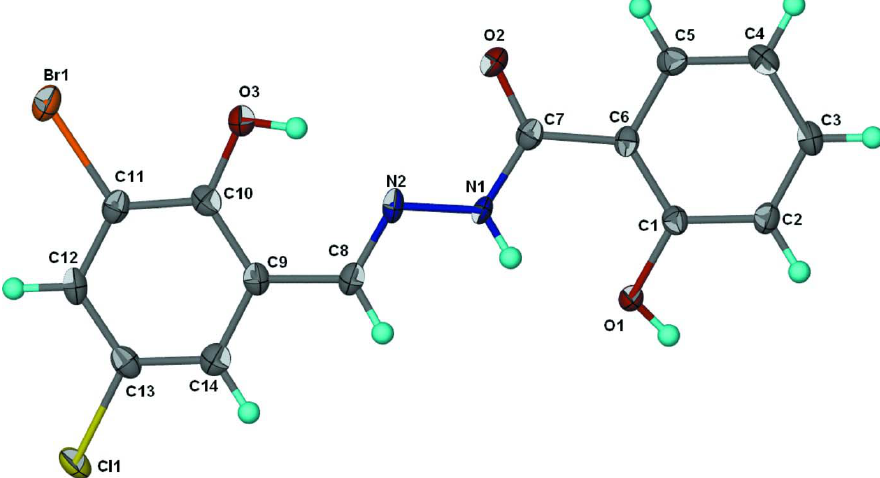
The molecular structure of (I) with atoms shown at the 70% probability level. Hydrogen atoms are drawn as spheres of arbitrary